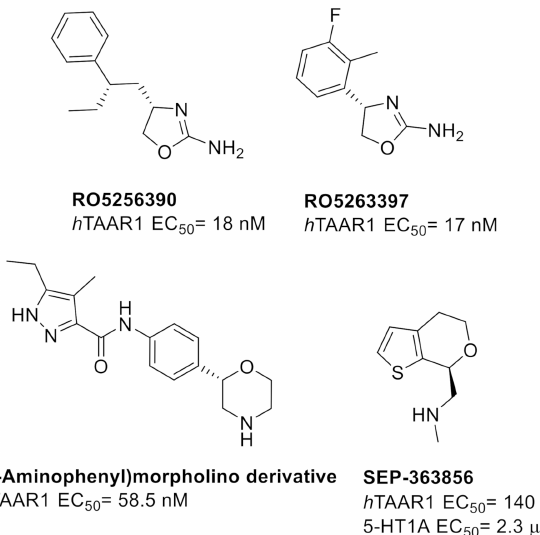
Figure1. Chemicalstructureandfunctionalactivityofthemostpromisinghumantraceamine-associated receptor 1 ( h TAAR1)